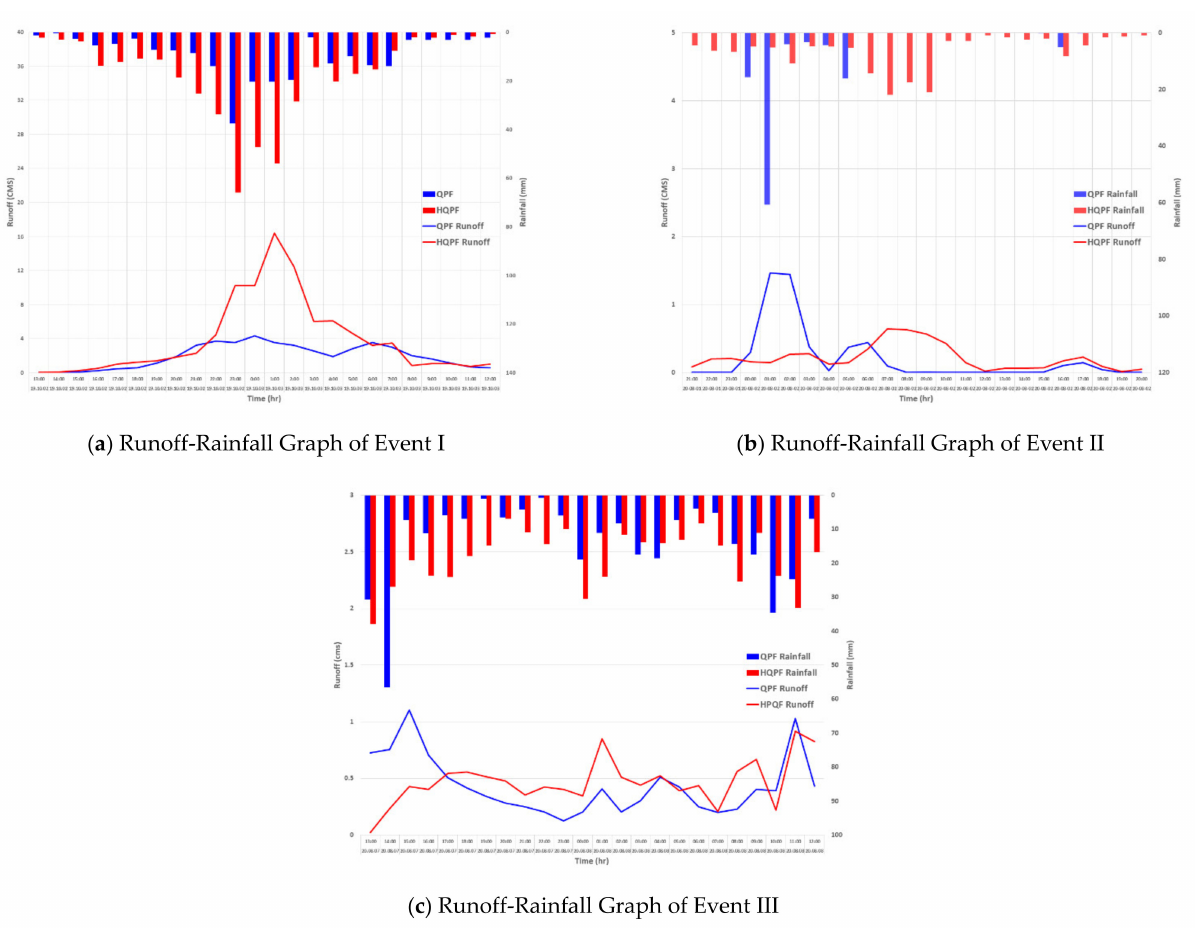
Figure 12. Runoff-Rainfall Graphs of QPF and HQPF. ( a ) is the Runoff-Rainfall graph of Event I Sinnam Village, ( b ) is the Runoff-Rainfall graph of Event II Namsan Village, ( c ) is the Runoff-Rainfall graph of Event III Sungduk Village. Where the blue bar graph is QPF Rainfall, the red bar graph is the HQPF rainfall, the blue solid line is the QPF runoff, and the red solid line is the HQPF